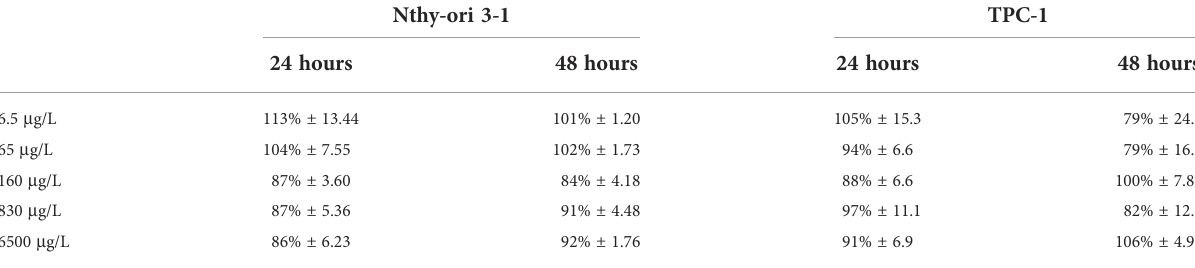
Values are presented as mean ±